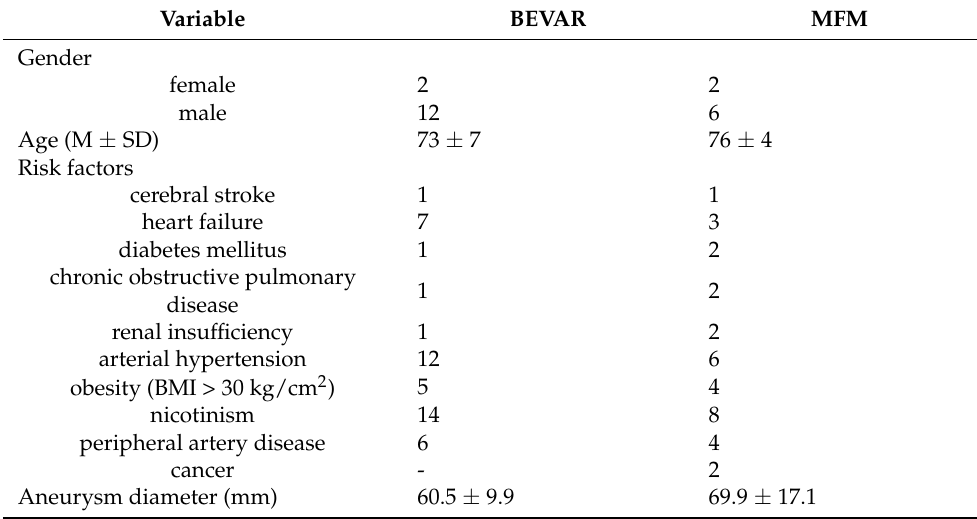
Table 1. The clinical and demographic characteristics of patients enrolled in the study.